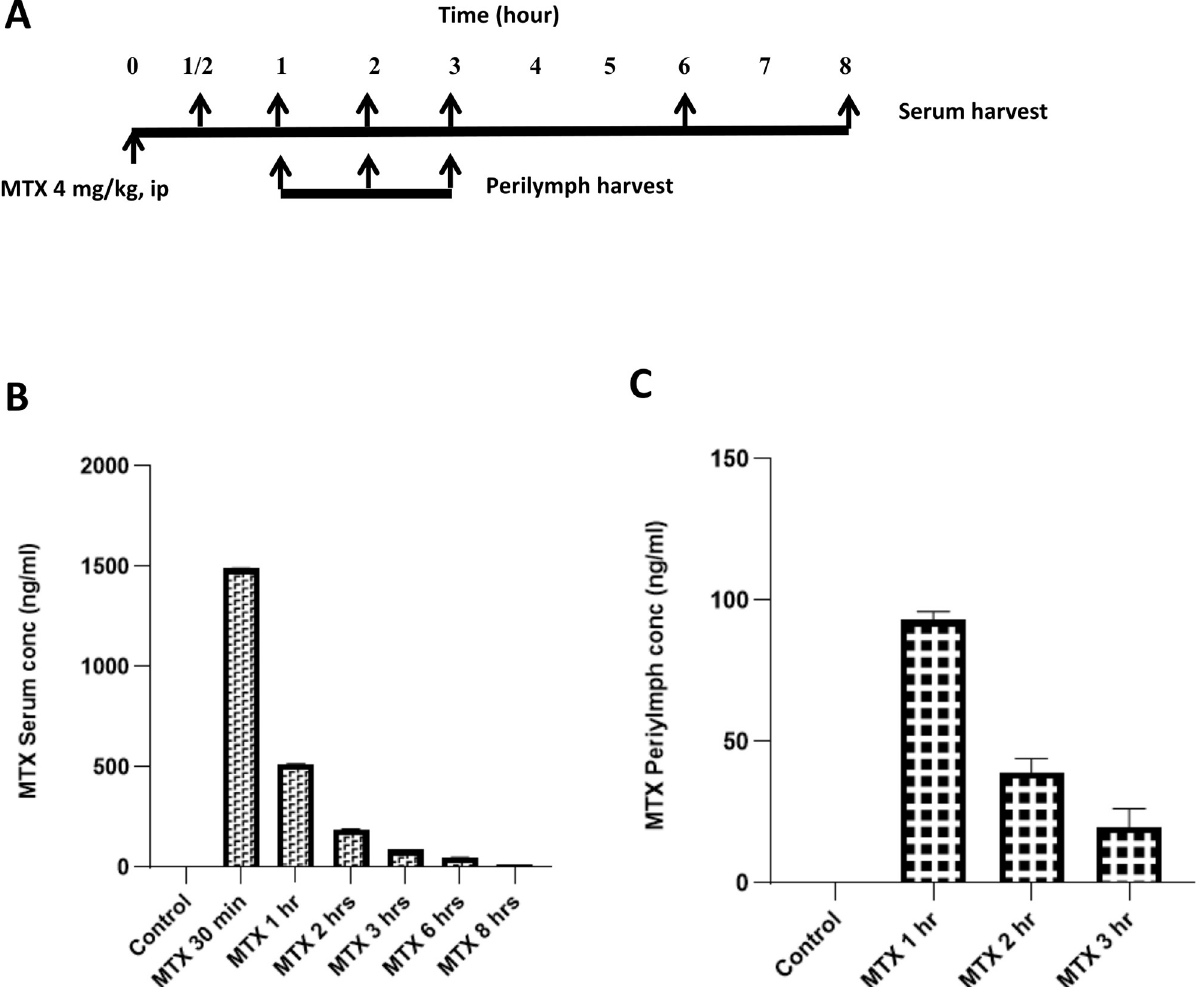
Fig 1. Methotrexate detection in mouse body fluid by LC-MS. A. Schematic diagram of time and treatment schedule. 0 hour represents the time of administration of 4 mg/kg of MTX to mice via an intraperitoneal injection; ½ , 1, 2, 3, 6, and 8 hours stand for the time points of serum harvest; 9 th hour indicates the time point for LC-MS analysis (upside). For perilymph, 1, 2, and 3 hours denote the moment perilymph was collected (below side); and 4 th hour is the time point for LC-MS analysis to assess the presence of MTX in the perilymph. B. Results of serum analysis and illustrates the level of MTX in the serum being peaked after 30 minutes and then gradually declining, suggesting that MTX is taken up by different tissues. C. MTX was detected in the perilymph 1 hour after its administration in mice, and gradually decreased in the subsequent hours. Each group contained three mice (n = 3).